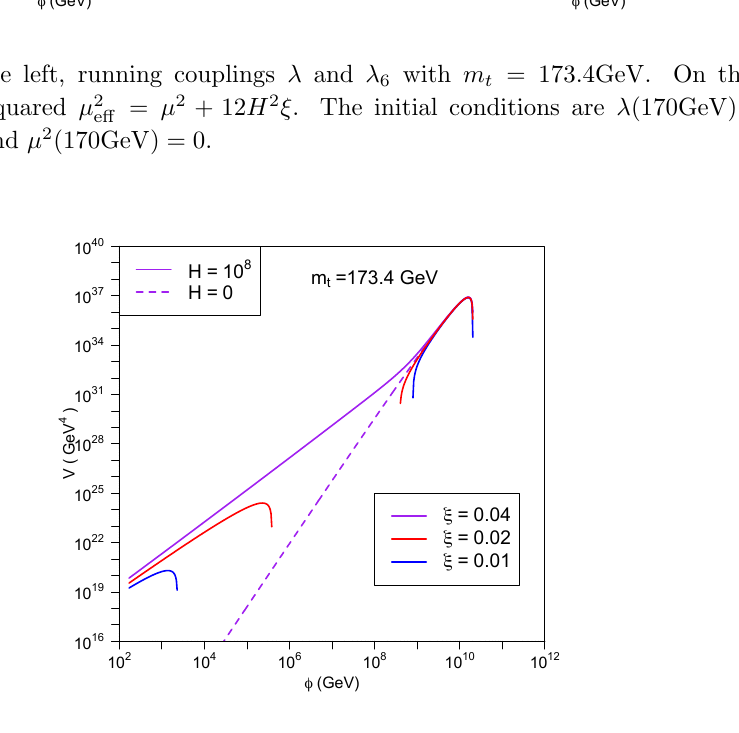
Note that for small initial values, the e(cid:11)ective mass becomes negative at Higgs (cid:12)eld values below the Planck scale. This can further drive the Higgs instability, and it can even give the potential a second maximum. This is illustrated by the potential plots in (cid:12)gure 2. A combination of small initial (cid:22) 2 and small expansion rate H leads to twin maxima. e(cid:11) The Higgs e(cid:11)ective potential has been used to (cid:12)nd the tunnelling exponents plotted in (cid:12)gure 3. The two plots show di(cid:11)erent values of the top quark mass, the (cid:12)rst one closest in